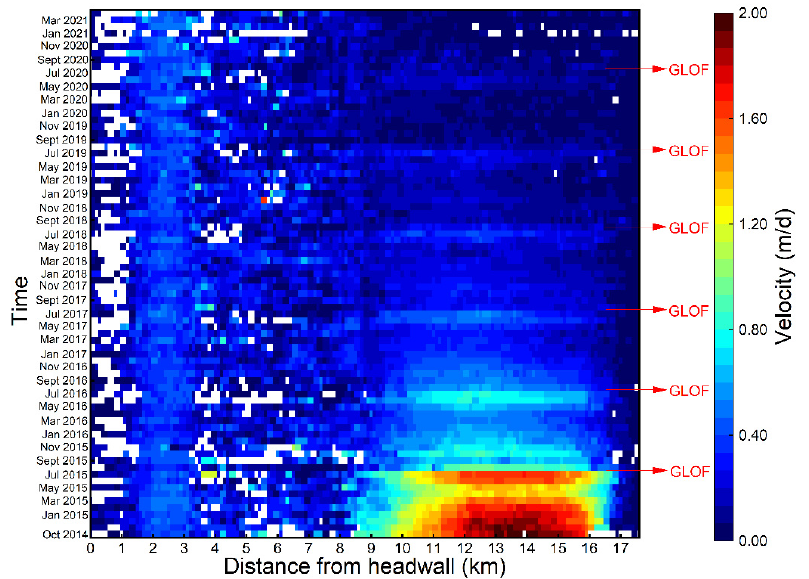
Figure 8. Spatial and temporal distributions in glacier velocity along the longitudinal profile in Figure 1 during 2014–2021.